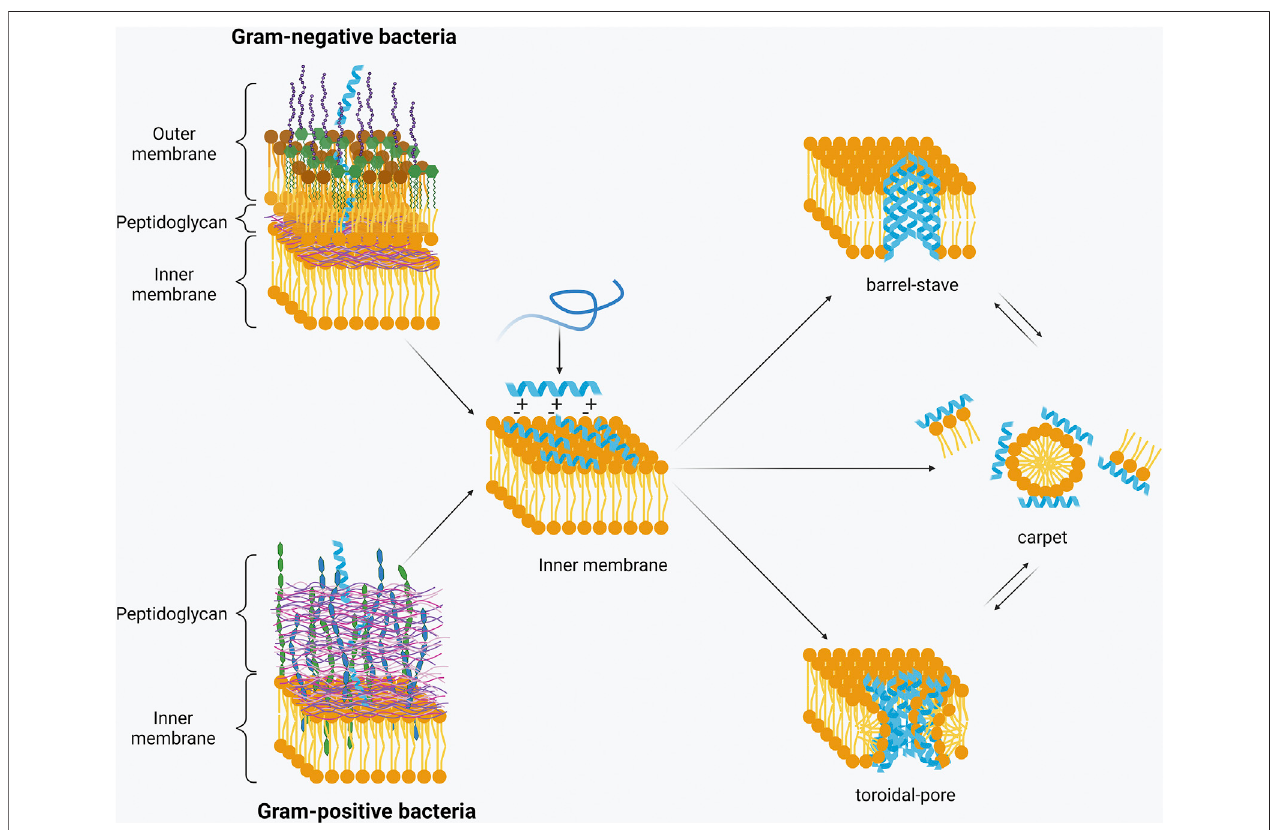
FIGURE 2 | Permeabilisation of the inner membrane. Upon interaction with the negatively charged bacterial membrane AMPs form a secondary structure. Once a thresholdconcentrationhasbeenreached,theyinsertintothemembranewiththreemodelsbeingthemostwidelyaccepted – barrel-stave,toroidalporeorcarpetmodel (Created with